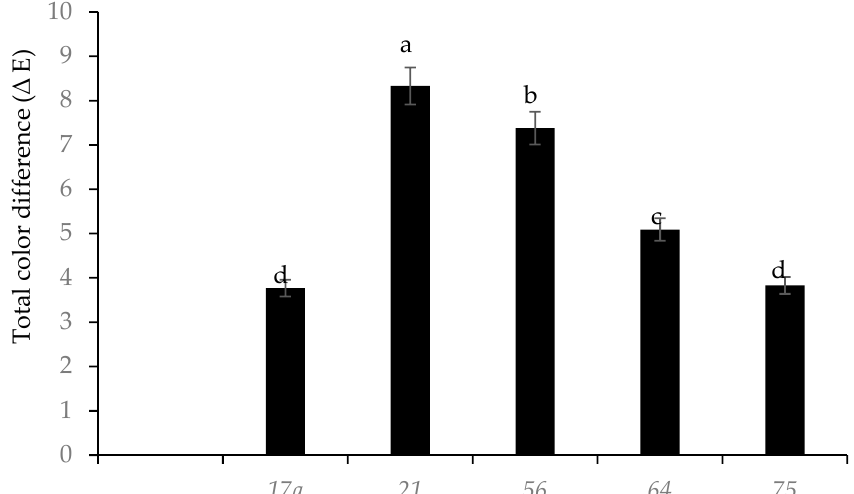
Figure 3. Influence of lactic acid fermentation with different LAB strains on color difference compared to raw ( Solanum retroflexum ) leaves. Each value represents the mean value of five replicate samples. Means followed by the same letter are not significantly different ( p < 0.05).